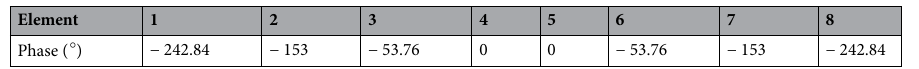
Table 2. Phase correction applied to each antenna element.